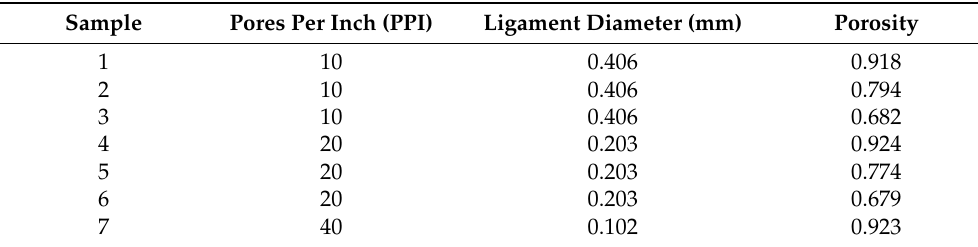
Figure 2. Boundary conditions of the battery module. Table 2. Physical properties of aluminium foam [35]. Reproduced with permission from [Applied energy]; published by [Elsevier], (2017).